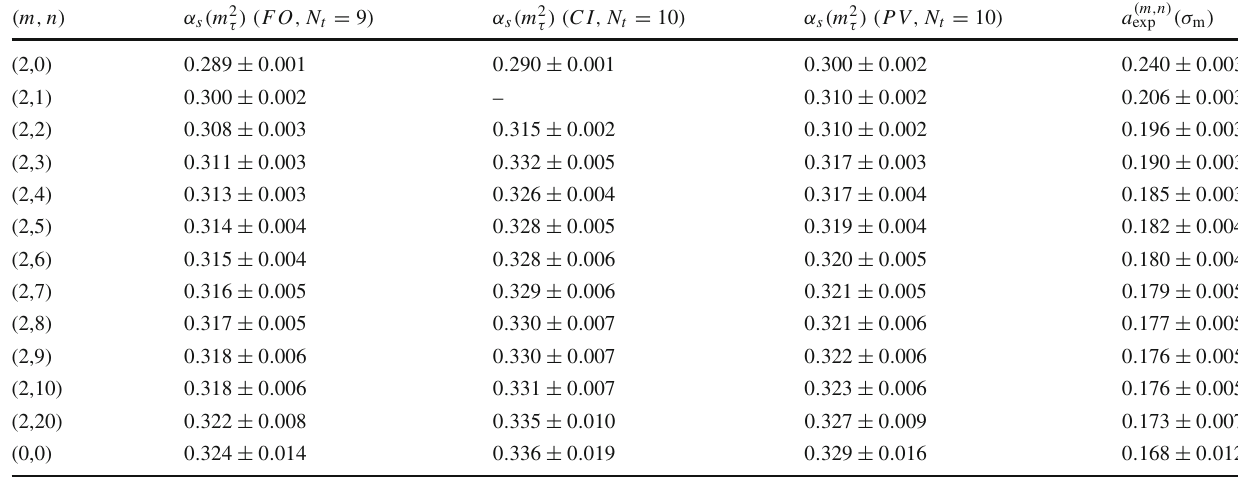
(which are not dominant) were included. In the last column we present the experimental values of these moments as extracted from ALEPH data. For ( m , n ) = ( 2 , 1 ) , the CIPT approach cannot achieve the exper- imental values of a ( 2 , 1 ) (σ m ) for any α